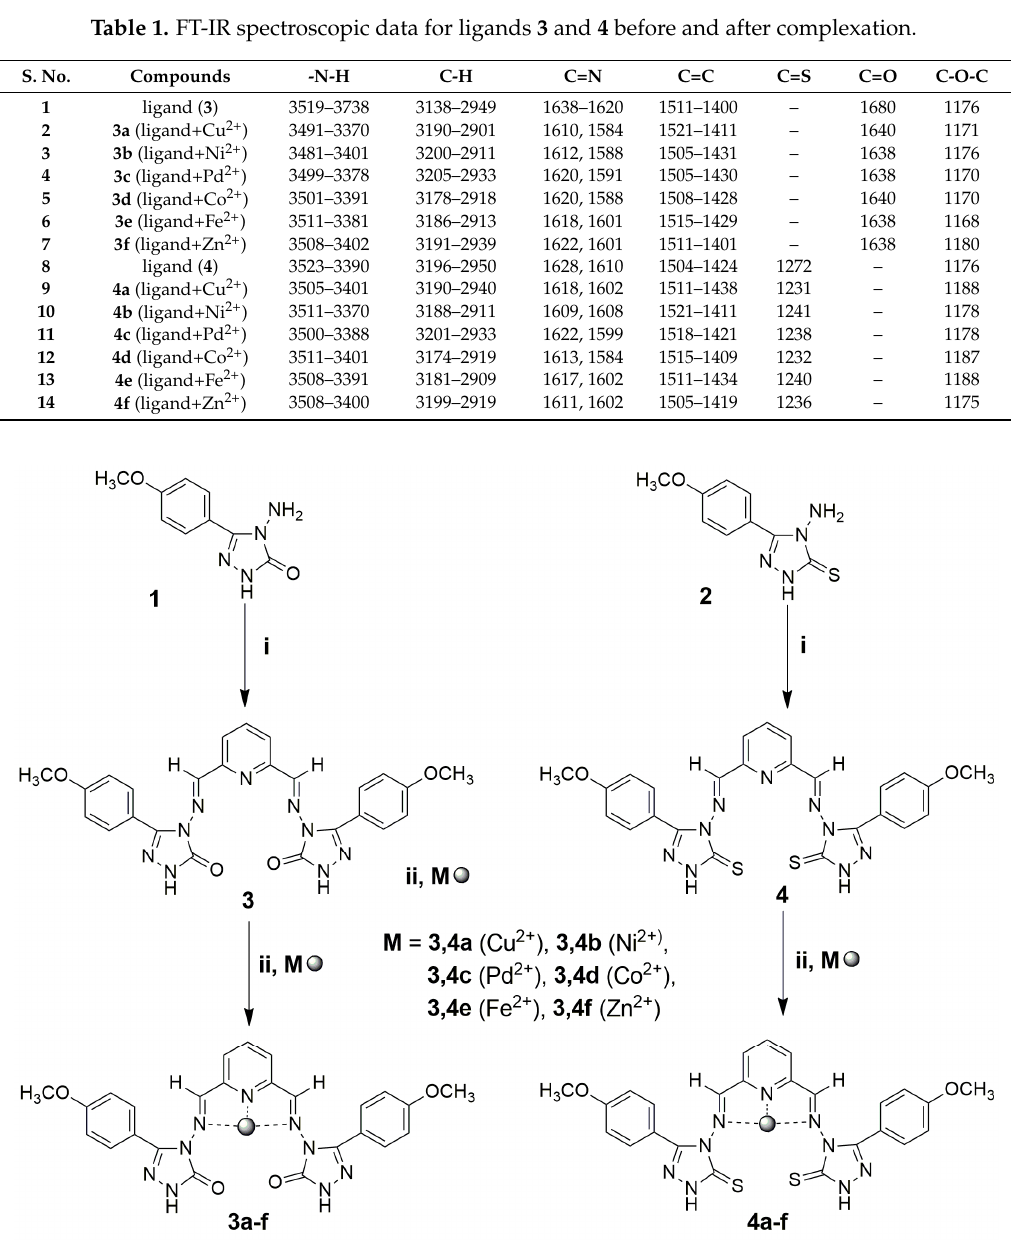
Table 1. FT-IR spectroscopic data for ligands 3 and 4 before and after complexation.